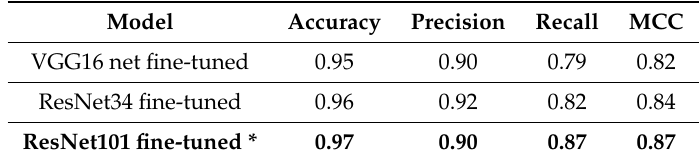
Table 7. Performance metrics of the obtained ConvNets computed over the test set discussed in Section 3.1.